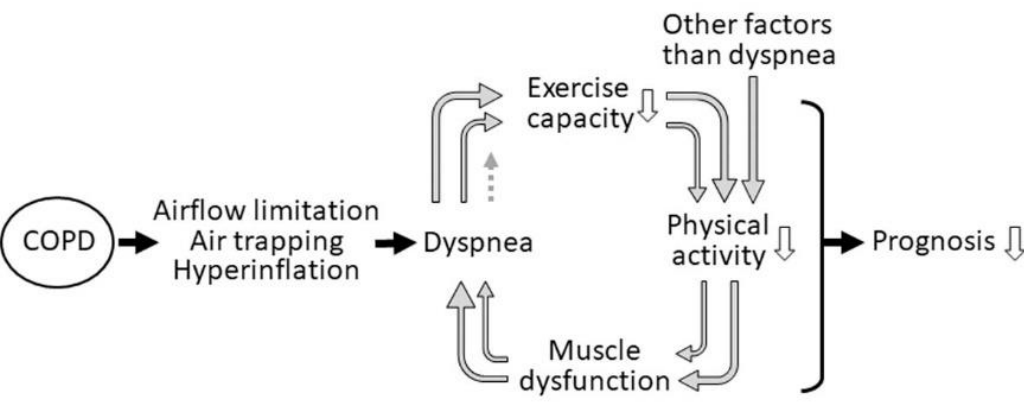
Figure 1. The downward spiral of inactivity in COPD. Physiological changes lead to dyspnea and decreased exercise capacity. Physical activity is reduced by decreased exercise capacity and other factors, such as psychological, socio-economic, comorbidities, and/or skeletal muscle weakness.